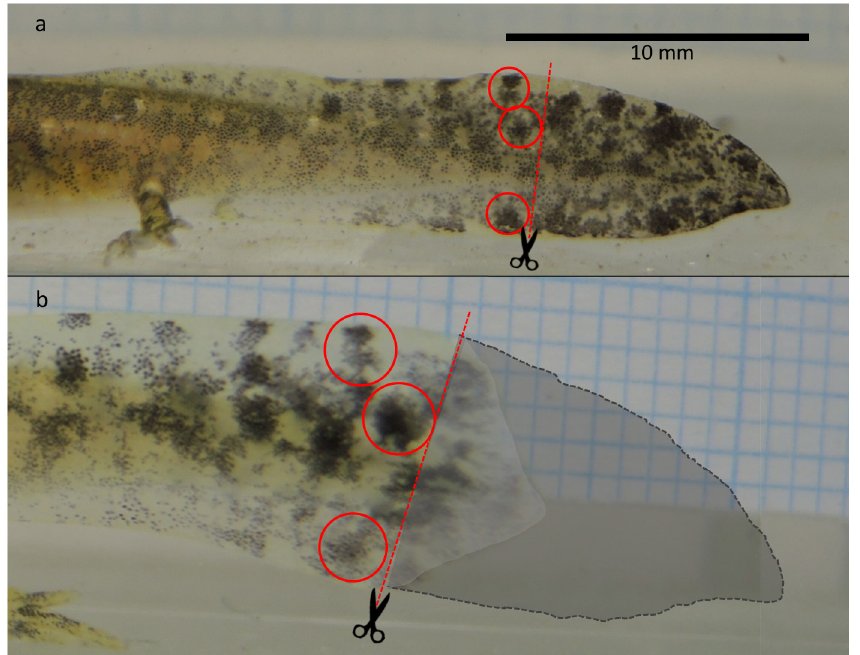
Fig 1. Lateral view of atail of S . infraimmaculata larva before clipping (a), and following a 37 day interval during which 29.4% of the tail area had regenerated (b). The shaded grey area (Fig 1b) denotes the relative clipped area taking into consideration the increase in total tail area. The position of the vertical incision, denoted by a dashed red line, was determined in Fig 1a relative to the position of the tail spots; a sample of three is enclosed in red